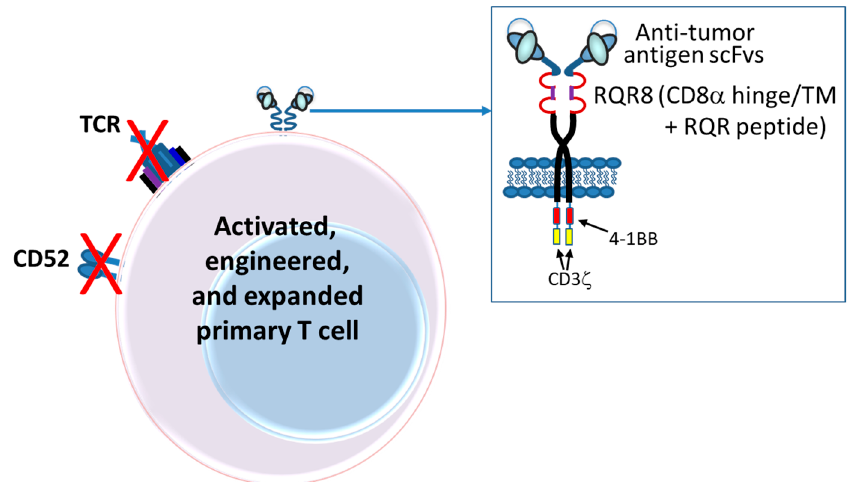
Figure 9. Drawing depicting the construction of an example allogeneic CAR-T cell. The CAR contains, from N-to-C terminus, anti-BCMA scFv, 136 amino acid residue RQR peptide, CD8 α hinge and transmembrane (TM) domain, 4-1BB costimulatory domain and CD ζ signaling domain in a cell in which TCR- α and CD52 have been knocked out using gene editing technology [301].